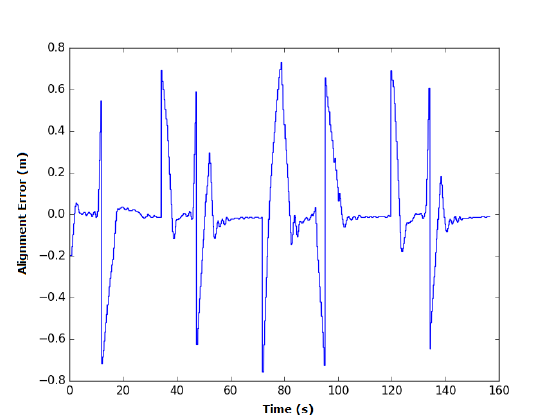
Figure 26. Variation of the alignment error during experiment 3 with Autonomous Mode.